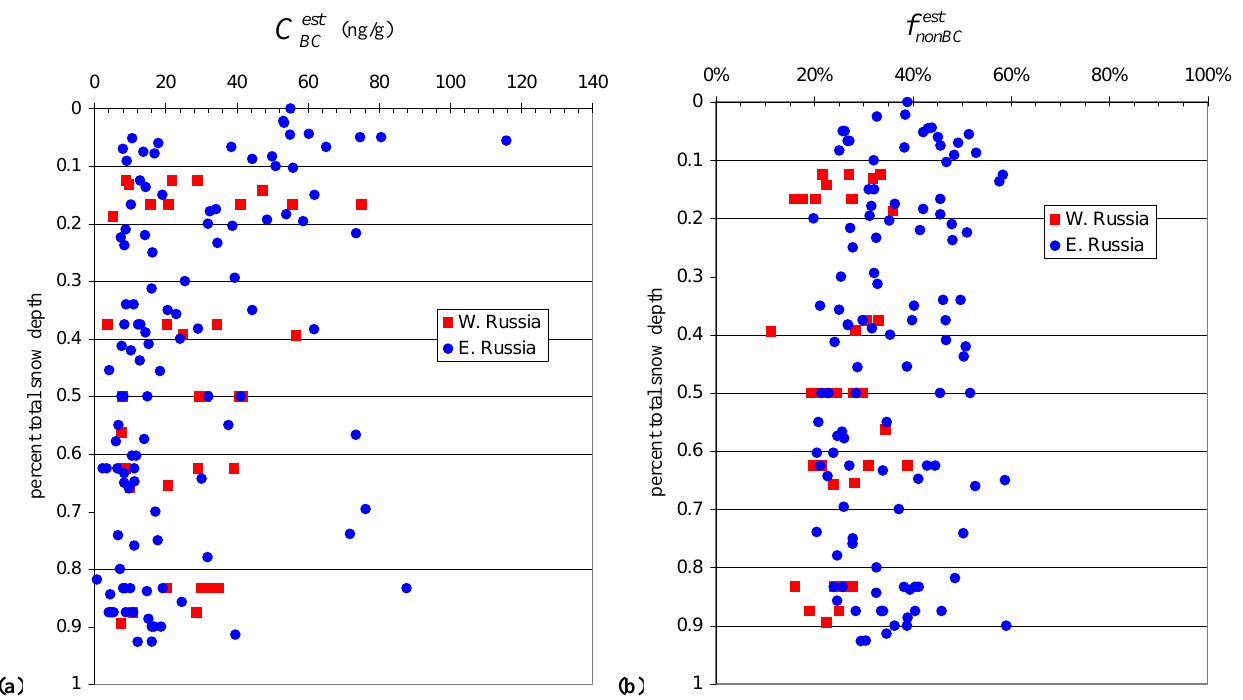
Fig. 12. As in Fig. 9, but for from West (2007) and East (2008) Russia. . Note that the scale for C est we have included data only where there were samples from more than three snow depths. This excludes much of the data from the Tiksi and Laptev Sea sites, where the snow was thin. Data from Vorkuta were also not included here.